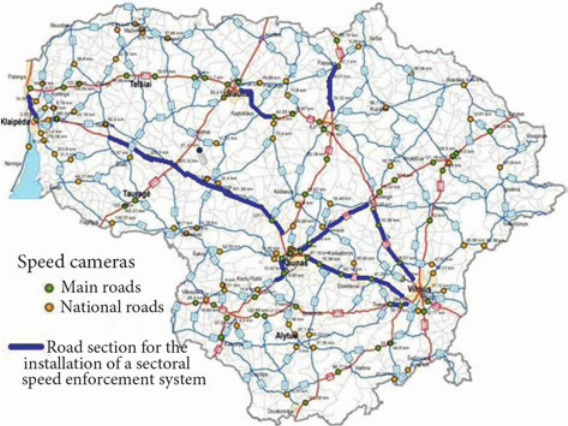
Fig. 4. Road sections suggested for the installation of a sectorial speed enforcement system on the roads of Lithuania